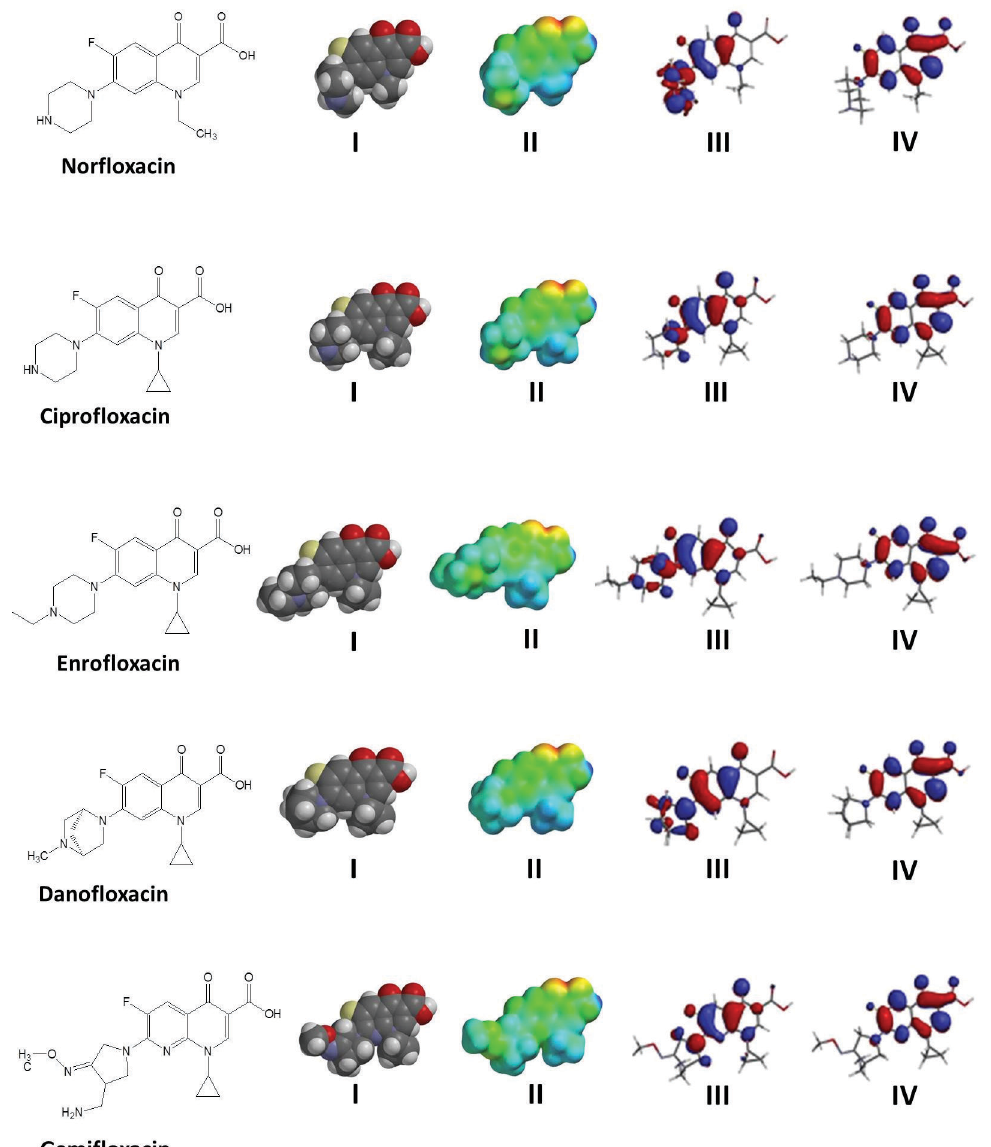
FIGURE 4 - Chemical structure, space filing model, MEPs, maps of HOMO and LUMO energy 3D distribution of fluoroquinolones. I – Space filing model; II- MEPs; III – HOMO energy; IV – LUMO energy. MEPs 3D, tube and space filling models obtained from DFT/3BLYP-6.31G* calculations using Spartan’08 for Windons with isosurface 0.002 eV. Color range: -60.000 (red) to 35.000 (blue) kcal mol -1 . TABLE IV - Energy of HOMO, LUMO and GAP eigenvalues obtained from DFT/3BLYP-6.31G* calculations using Spartan’08 for Windows Quinolone E (-) eV E (-) eV GAP (-) HOMO LUMO